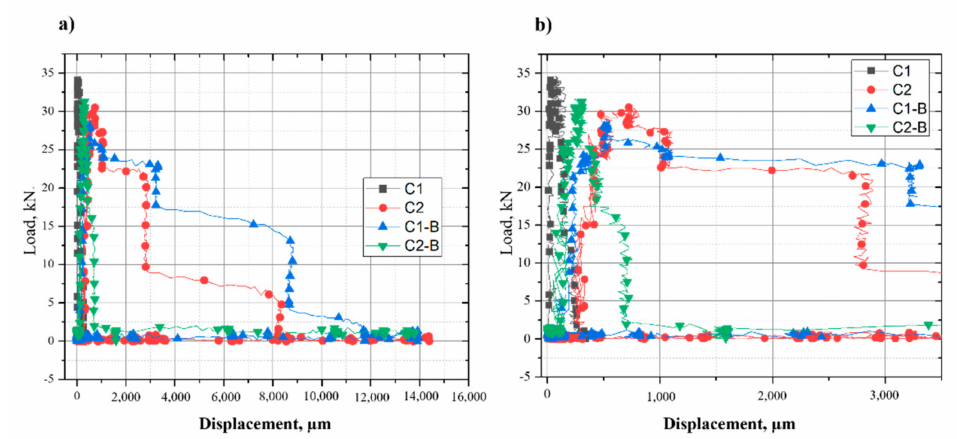
Figure 15. Load versus displacement behavior of the free fall tests, ( a ) full assay, and ( b ) ampli- fied